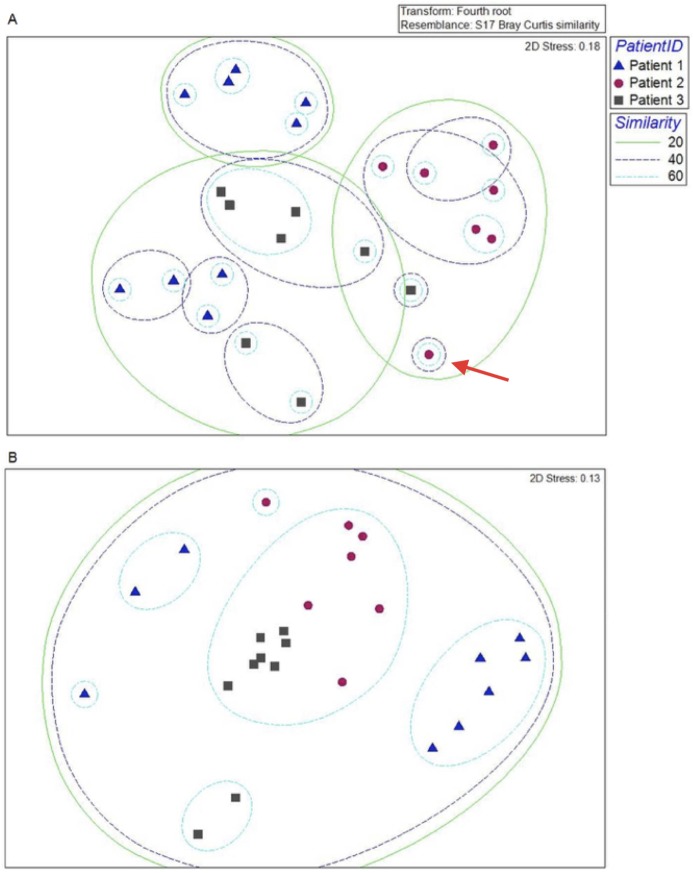
MDS plot showing inter-patient differences in microbial communities of the three patients at time points of probiotic treatment and post-treatment.Data are shown for T-RFLP analysis (A) and metacommunity sequence analysis (B). The microbial flora for Patient 1 (Blue triangles), Patient 2 (Red circles) and Patient 3 (Grey squares) were plotted for each time point collected. The red arrow indicates the pre-UTI sample for patient 2. The contours group samples with a given percentage of similarity (20%, 40% and 60%) based on composition and relative abundances of taxa present.